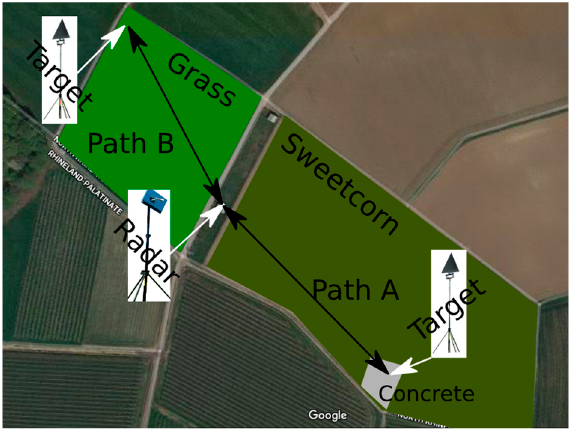
Figure 6. Illustration (from Google Earth) of the experimental setup in the fields of Wachtberg. Two different propagation paths were measured with the same radar and the same standard target. Sweetcorn was grown in the field of propagation path A (186 m), whereas grass was grown on the field of propagation in path B (159 m).